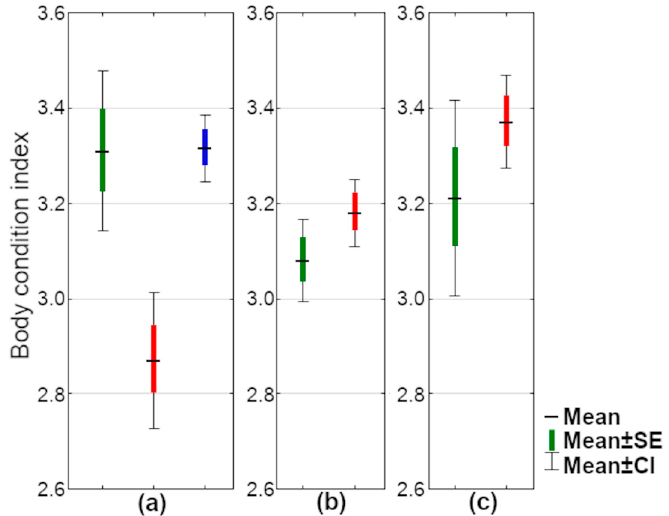
Figure 3. Body condition indexes of C. glareolus in Juodkrant ė ( a ), Lukštas ( b ), and Naudži ū nai ( c ) colonies. Control zone shown in green, active zone in red, abandoned zone in blue.